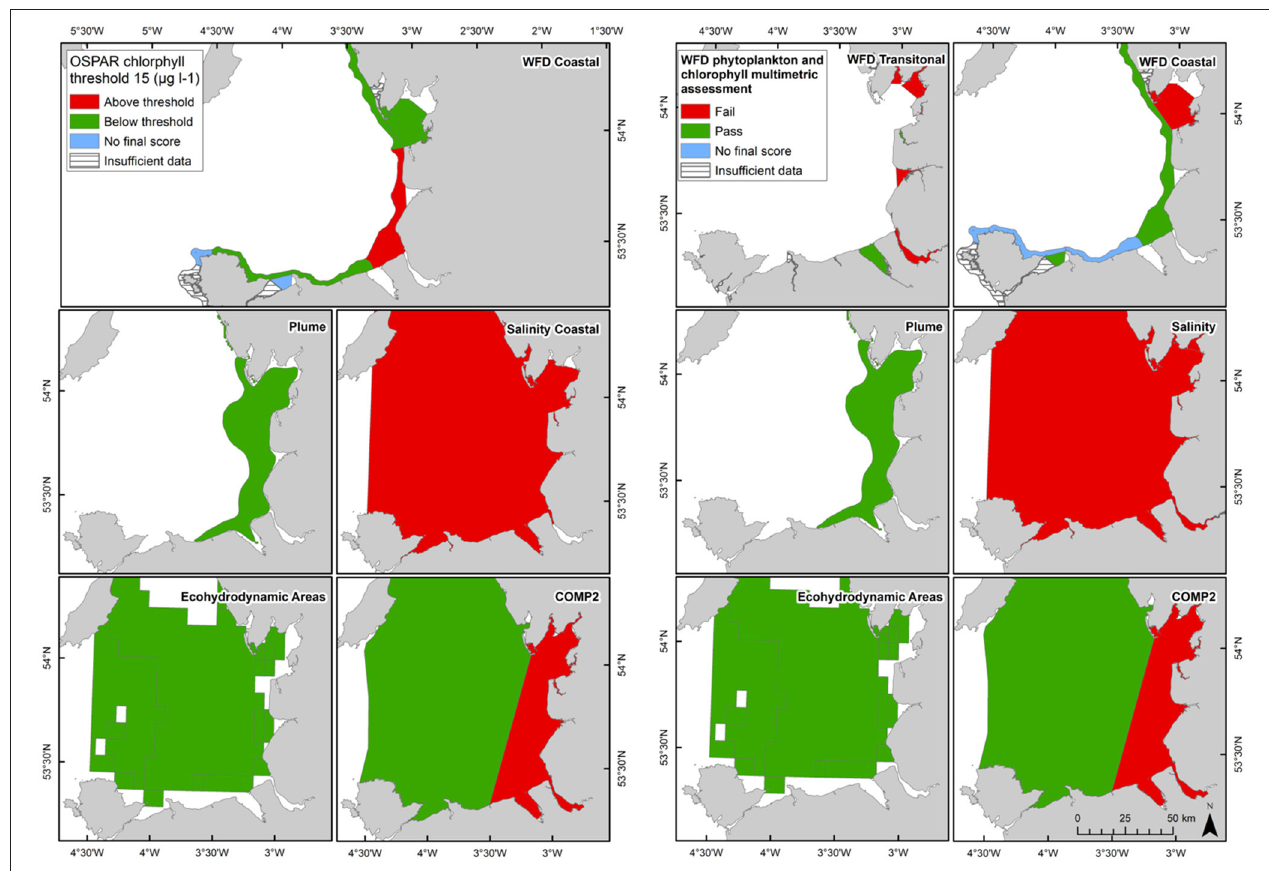
FIGURE 9 | Outcomes for the OSPAR chlorophyll- a assessment (left) and WFD combined chlorophyll-phytoplankton assessment (right) for Liverpool